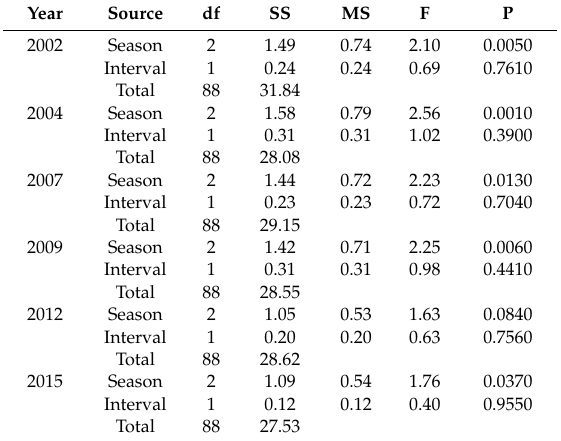
Table 1. Summary statistics for Permutation Multivariate Analysis of Variance (PERMANOVA) of understory species composition in relation to season and interval of burning for each sampling year.